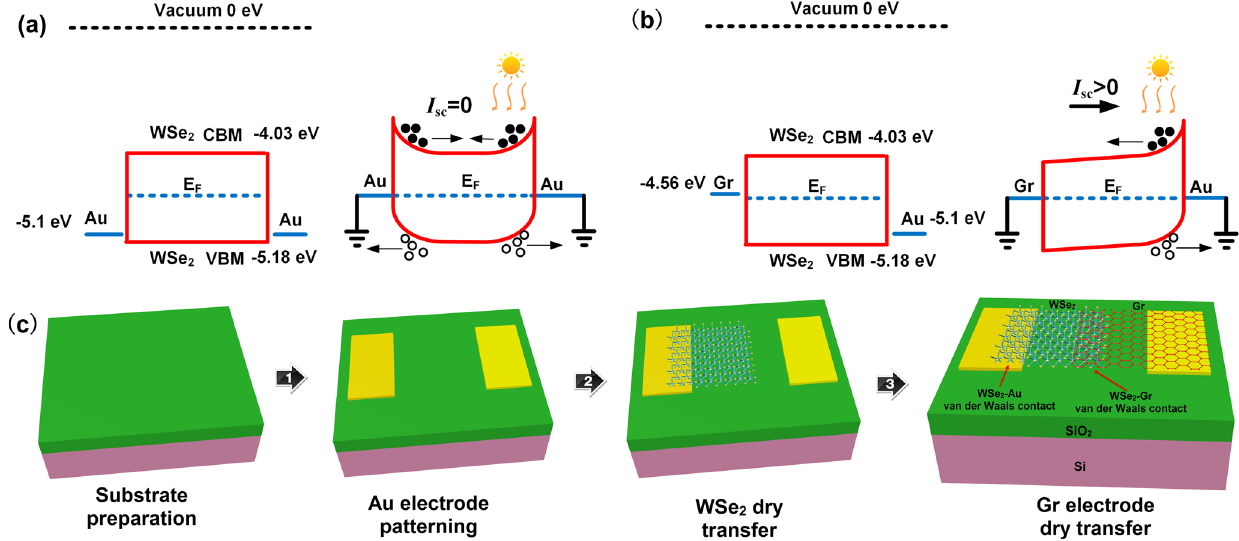
Fig. 1 Operational principle and the fabrication process of the photodetector. Band alignment of the Metal – WSe 2 – Metal structures with a Au as the two contact electrodes and b Au and multilayer graphene as the two contact electrodes, respectively, where the asymmetrical Schottky barriers at the two sides enabling a non-zero short-circuit current under light illumination. c Three-dimensional schematic of the process fl ow to fabricate the graphene – WSe 2 – Au